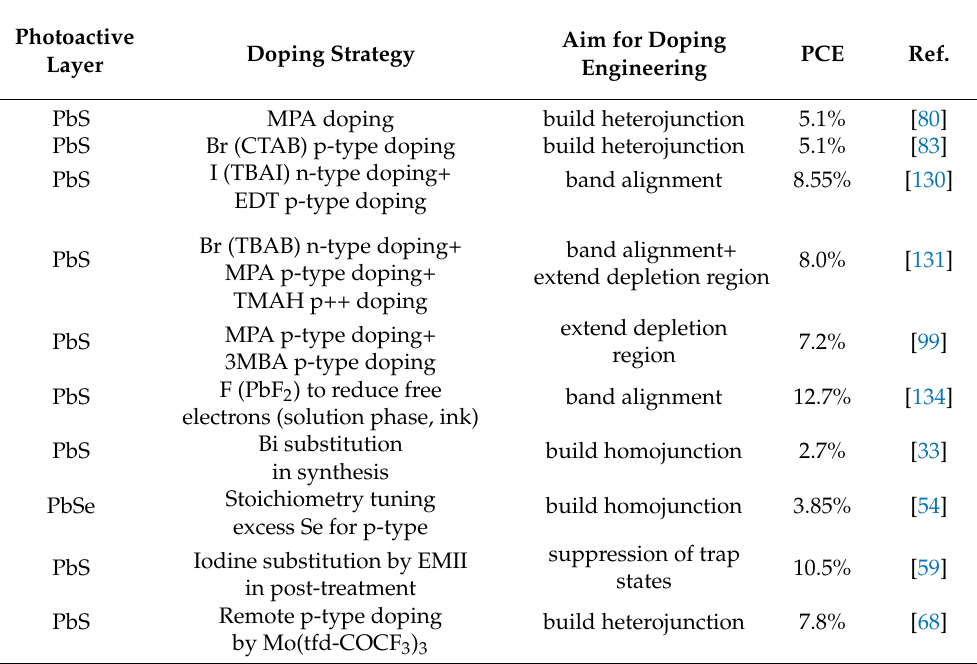
Table 5. Summary of high-efficiency lead chalcogenide CQD solar cells by doping engineering.